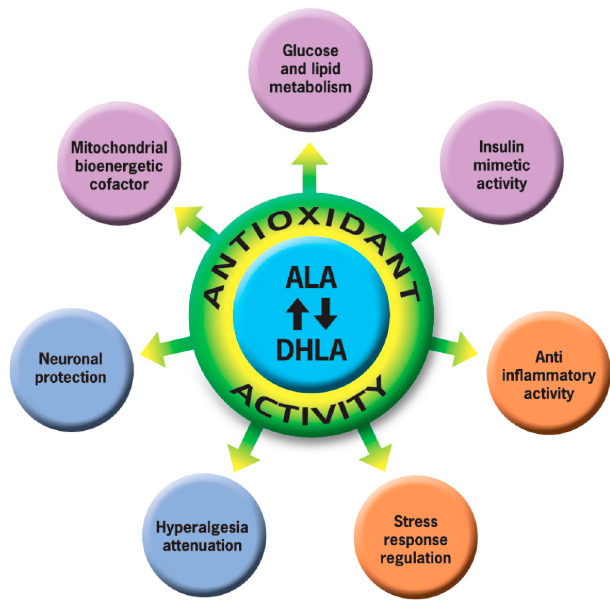
Figure 1. Biological functions of α -lipoic acid. α -lipoic acid (ALA) and its reduced